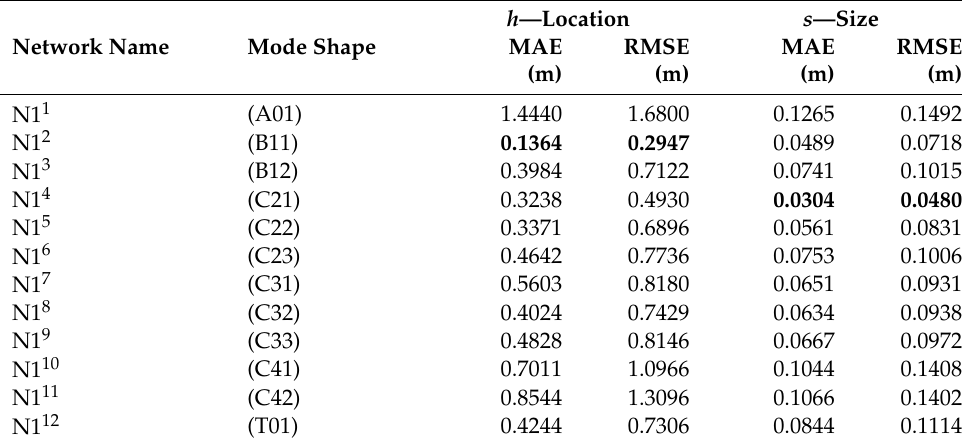
Table 4. The results of the identification of { h , s } on the basis of single mode